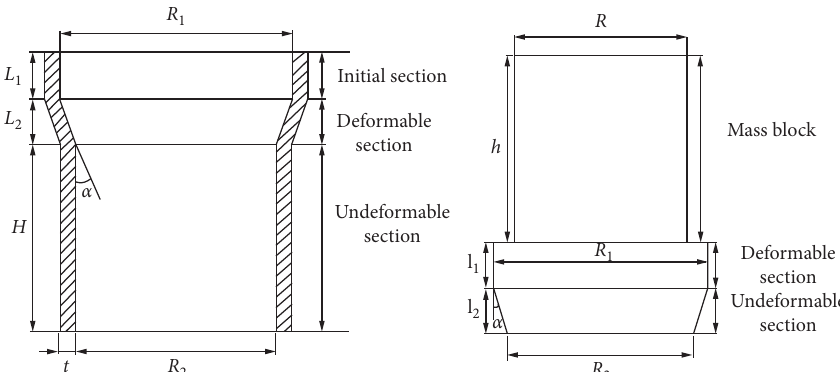
Figure 1: Research subject ( L 1 : length of initial section; L 2 : length of deformable section; H : length of undeformable section; t : wall thickness of metal tube; R 1 : inside diameter of initial section; R 2 : inside diameter of undeformable section; α : half cone angle; h : height of mass block; R : diameter of mass block).